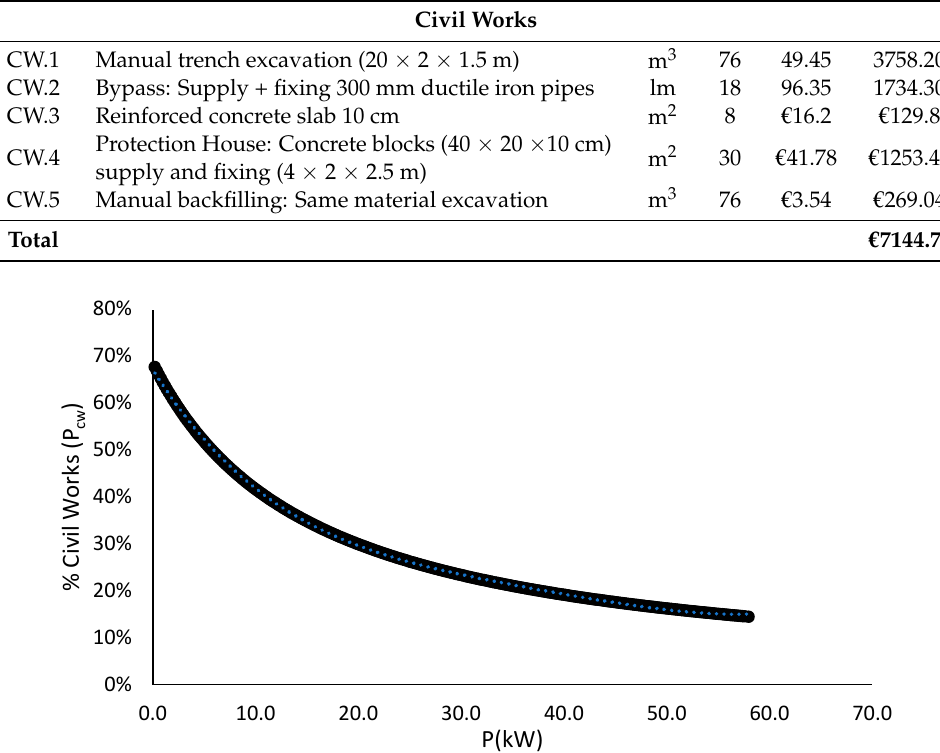
Table A1. Summary of the parties accounted in the civil work costs.